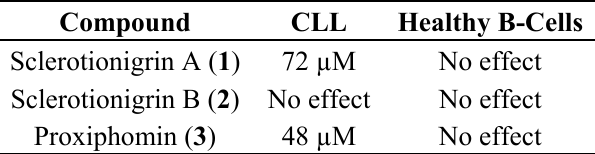
values for compound 1 – 3 50